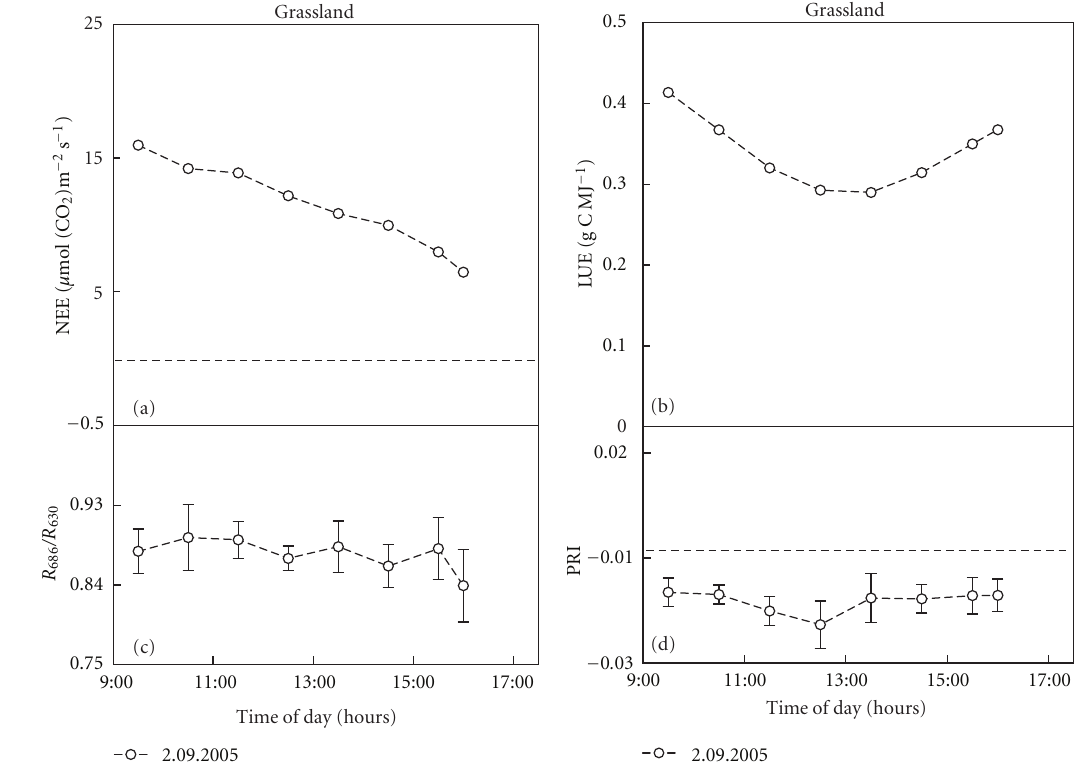
Figure 4: Daily courses of calculated net ecosystem exchange of CO 2 (NEE a) and light use e ffi ciency (LUE b) in grassland ecosystem and corresponding daily course of R 686 / R 630 (c) and Physiological Reflectance Index (PRI, ( R 532 − R 570 )/( R 532 + R 570 )) (d) vegetation indexes (VIs) over experimental plot of 4m 2 measured via hyperspectral imaging sensor (AISA Eagle, Finland). Each data dot of eddy-covariance parameters represents an average of a half-hour measurement, and only corresponding with AISA scans are shown. VIs data dots represent an average of more than 400 000 image pixels (i.e., an average of one image scan acquired in half and one hour intervals and error bars show ± s.d.). Dashed line shows zero value of the y